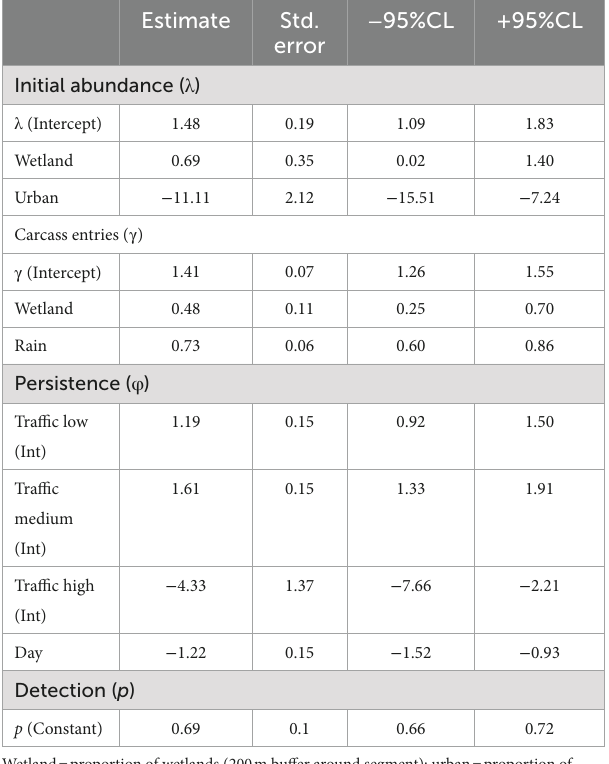
TABLE 1 Coefficient estimates obtained from the dynamic N-mixture model applied for dependent double-observer counts of amphibian